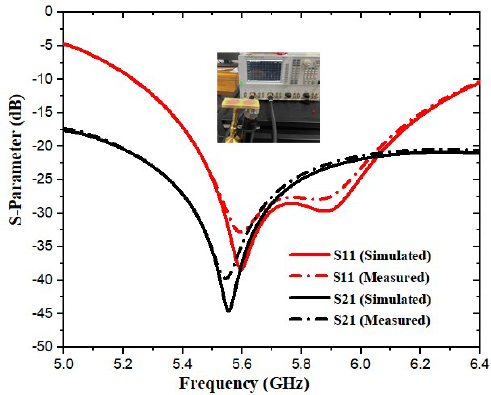
Figure 11. Simulated and measured S11/S21 of the